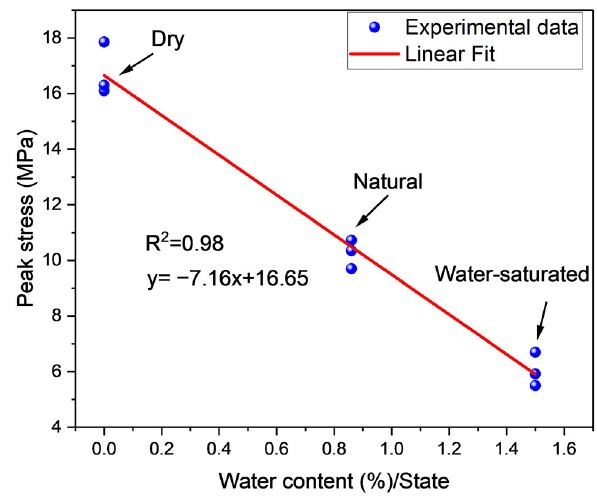
Figure 7. Correlation of different states of coal and elastic modulus.